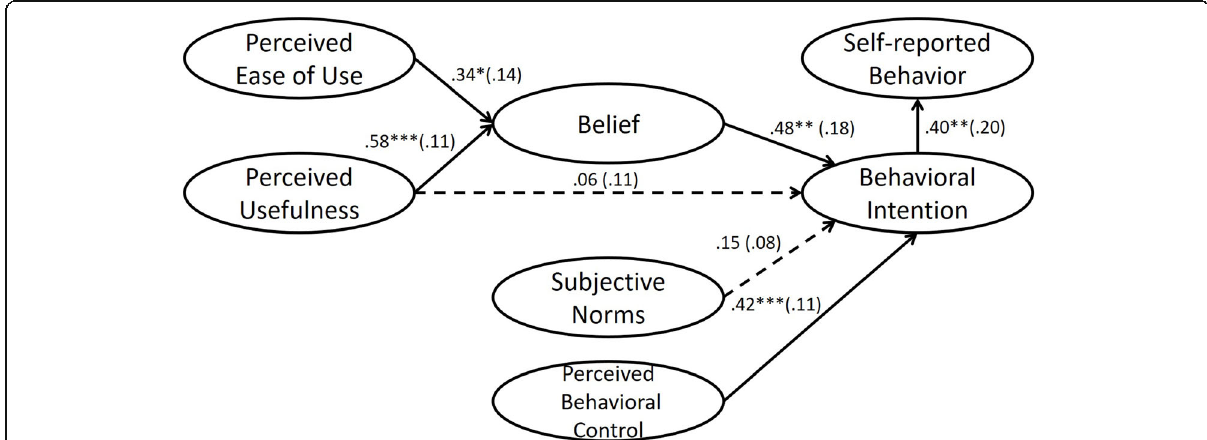
Fig. 14 The TTBIM for the NoPDP group ( n = 58). Solid lines indicate significant associations, and dotted lines indicate nonsignificant associations. Arrows indicate the direction of the relationships. Figures in parentheses represent the standard error ( SE ). *** p < .001; ** p < .01; * p < .05